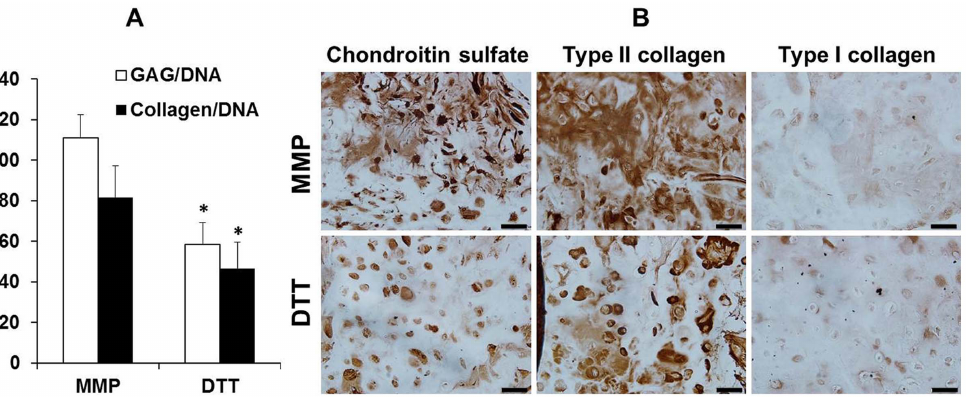
Figure 5. The analysis of the cartilaginous matrix contents of the hMSC-seeded hydrogels. GAG and collagen content (normalized to the DNA content) of hMSC-laden HA hydrogels (A) and immunohistochemistry staining of the hydrogel constructs against chondroitin sulfate, type II and I collagen after 28 days of culture (B), Bar =50 m m, *p , 0.05 vs. MMP group (n=4).